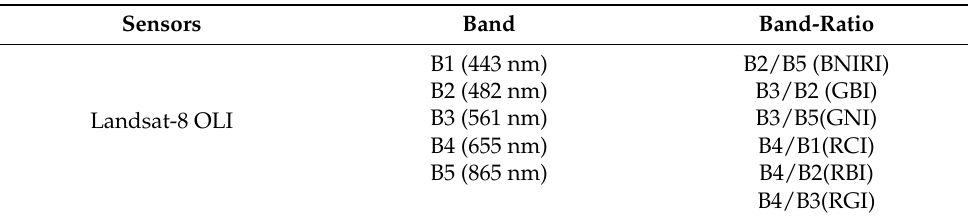
Table 1. The input bands and band combinations of the Landsat 8 OLI.